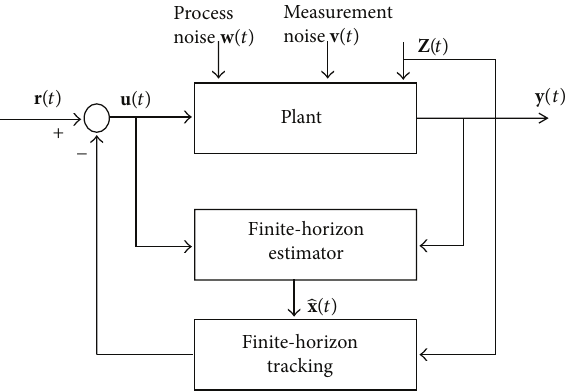
Figure 5: Summary of continuous-time nonlinear